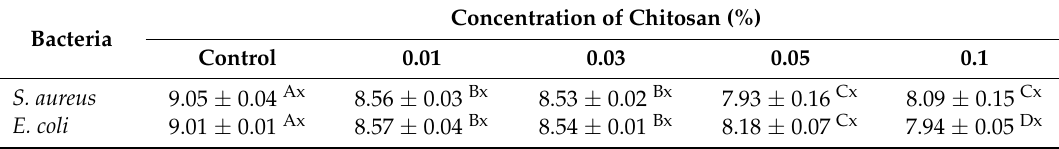
Table 3. Effect of chitosan concentration on the viability of S. aureus and E. coli (Log CFU/mL) a,b . Bacteria